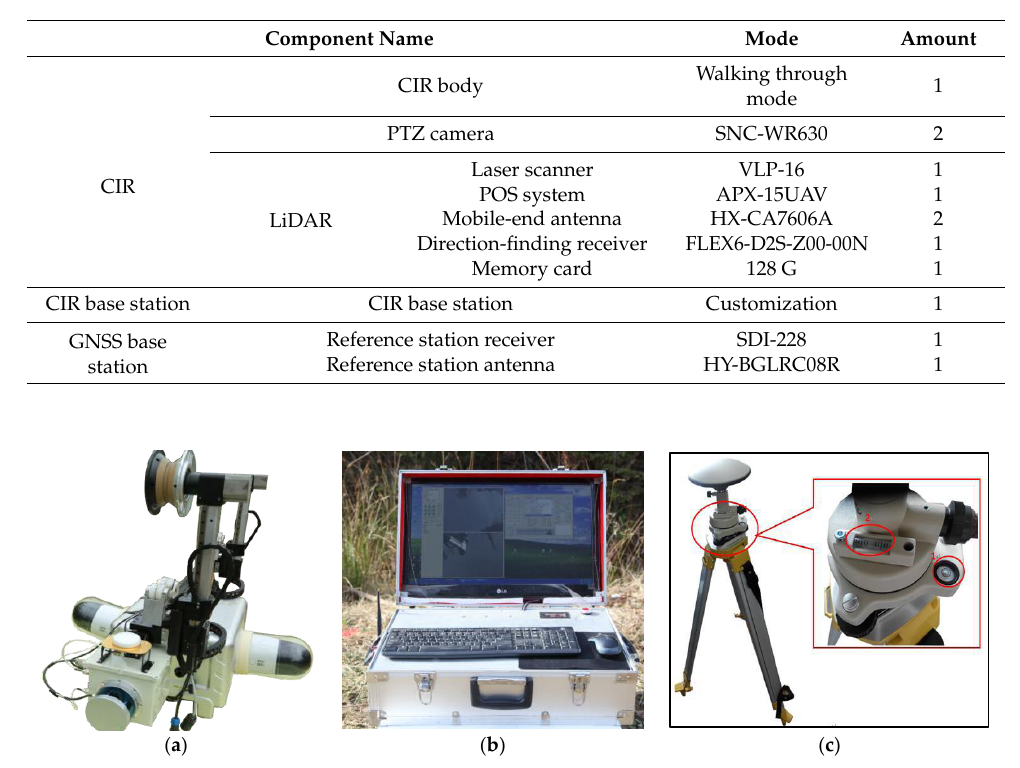
Table 1. Key components of CIR autonomous inspection system.